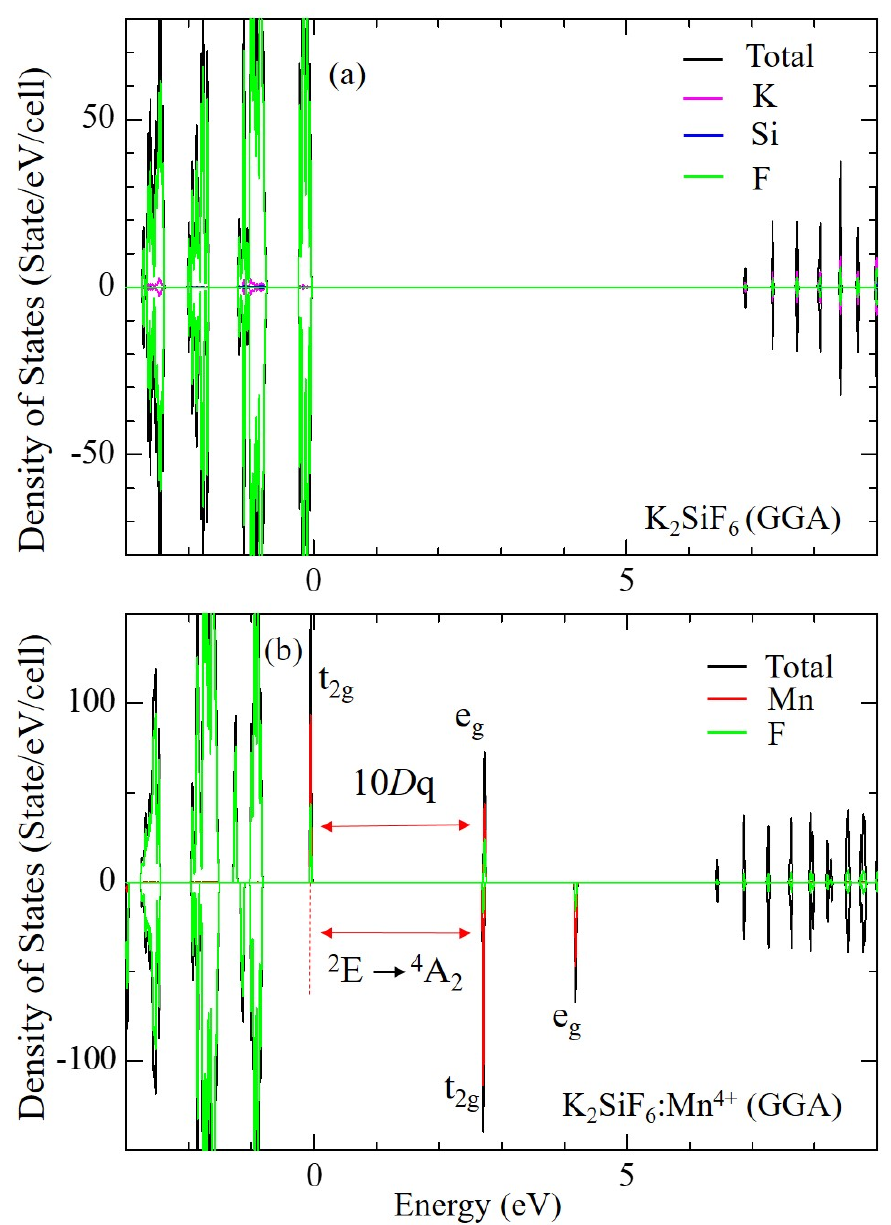
Figure 4. Calculated electronic density of states of ( a ) non-doped and ( b ) Mn 4+ -doped K 2 SiF 6 . To discuss the influence of pressure on the electronic structure, calculated DOSs of KSF:Mn 4+ are compared among those at different pressures between 0 and 40 GPa, which Mn 4+ ion, i.e., up-spin and down-spin states of t 2g and e g , are plotted in Figure 6. As the